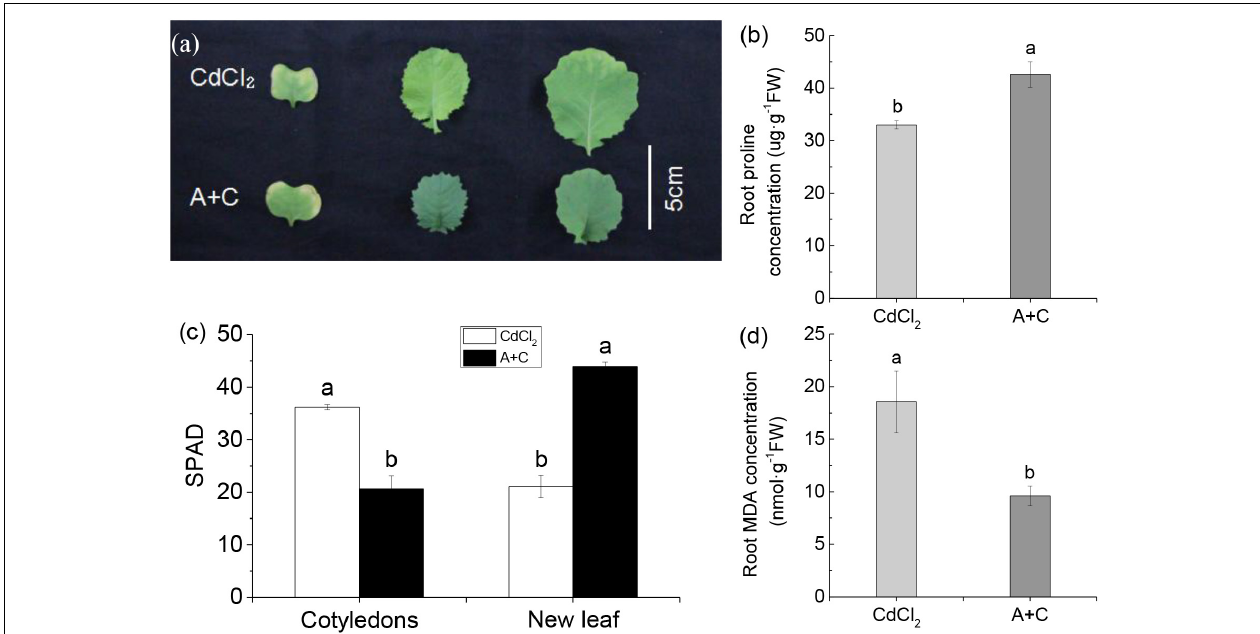
FIGURE 5 | Under Cd stress, B. napus (814) showed stronger tolerance after adding exogenous ABA. (a) Photograph showing higher tolerance of the treatment with 5 µ M exogenous ABA and 10 µ M Cd (A+C) as compared with 10 µ M Cd treatment. The leaves from left to right are cotyledons, the first new leaf and the second new leaf. (b) Root proline concentration in different treatments. (c) The SPAD of and new leaf. (d) Root MDA (Malonaldehyde) concentration in different treatments. Data represent means ± SE ( n = 4). Bars with the same letter indicate no significant difference at P < 0.05 level by the method of